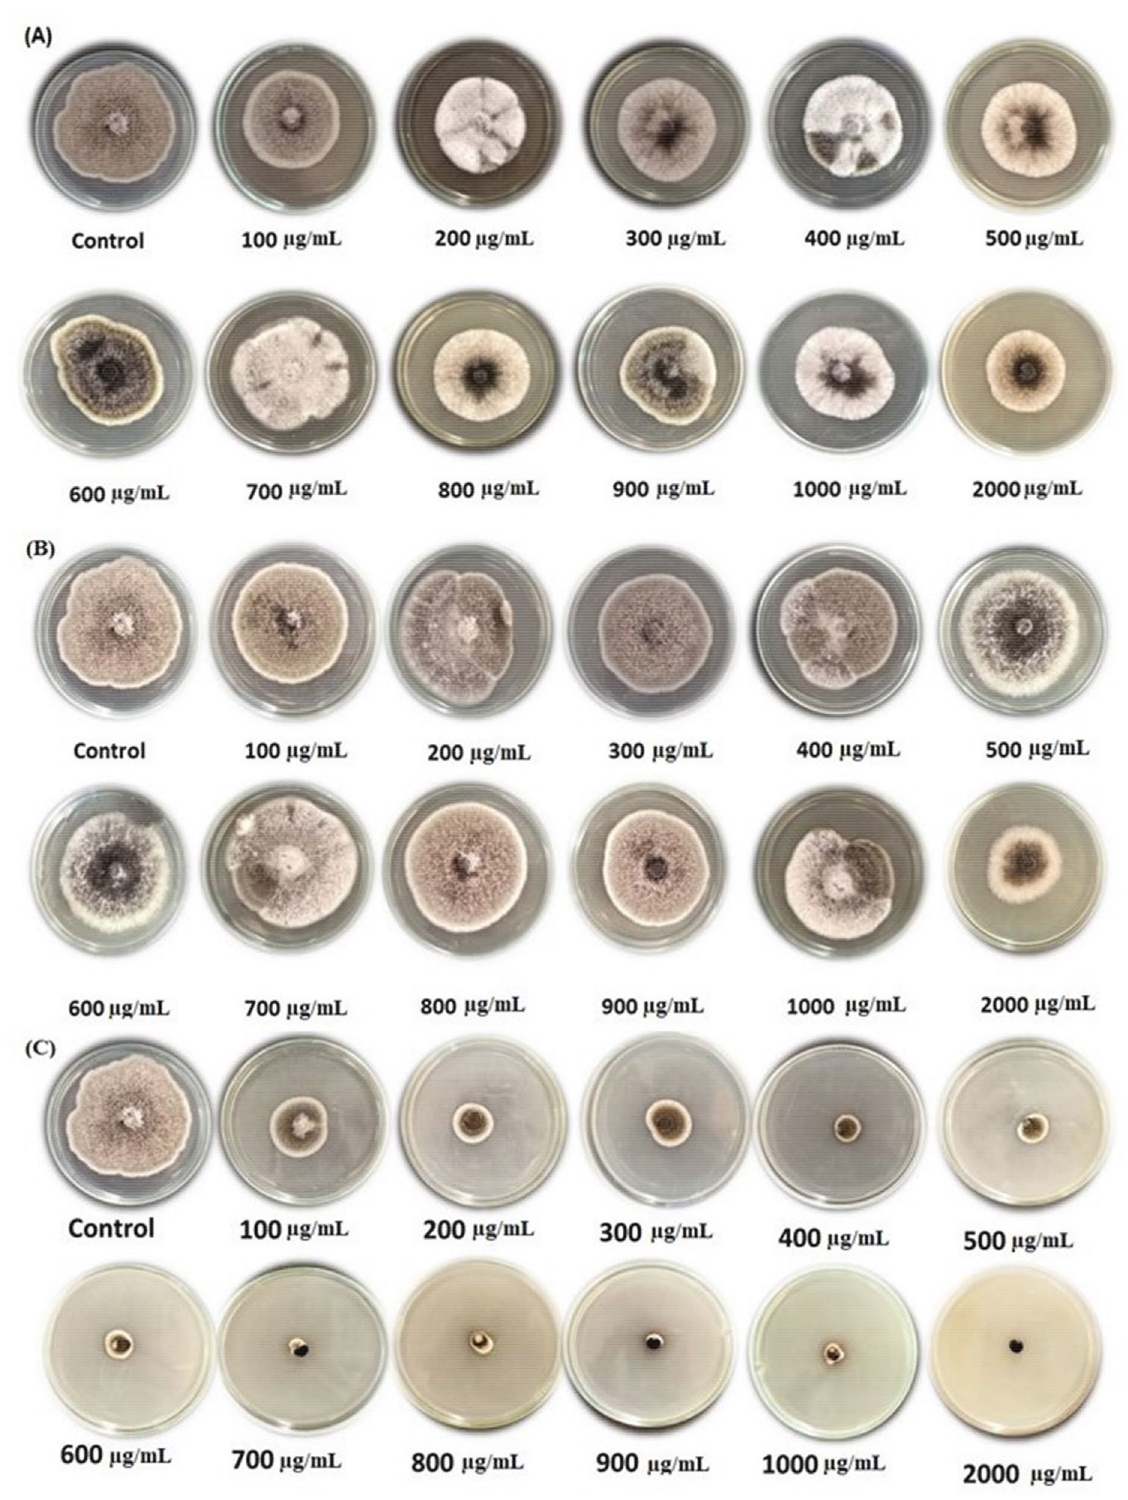
Figure 4. Visual observation of the antifungal activity of U. dioica extract ( A ), D. viscosa extract ( B ), and Ridomil fungicide ( C ) against the growth of A. alternata